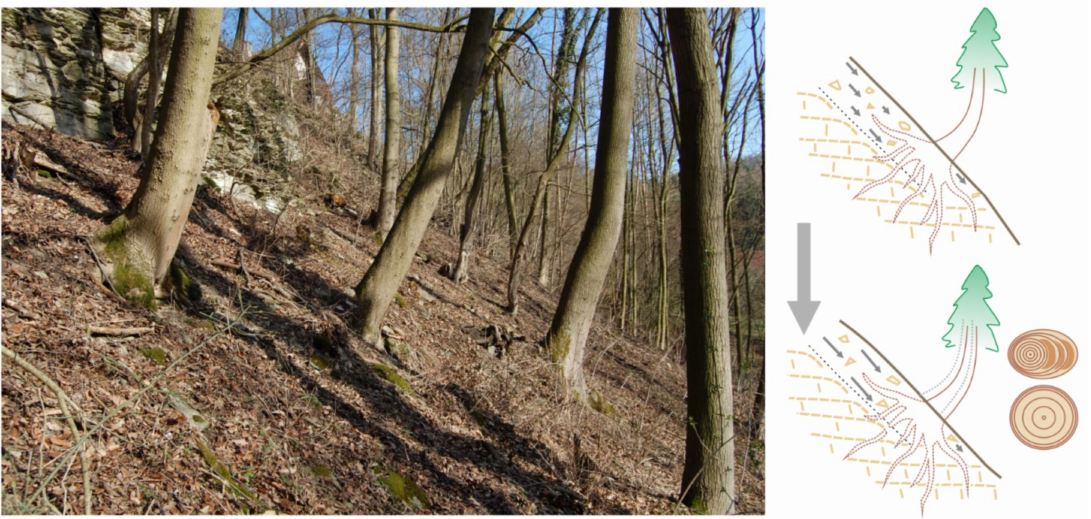
Figure 10. The effect of creep movements to tree